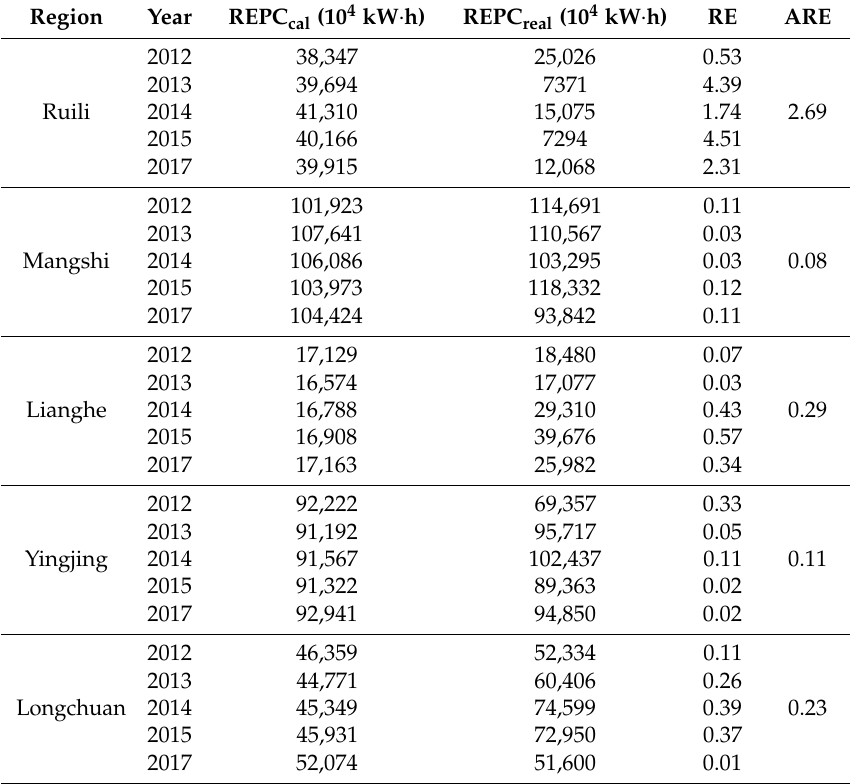
Table 6. The calculation results of RE for the linear regression model.